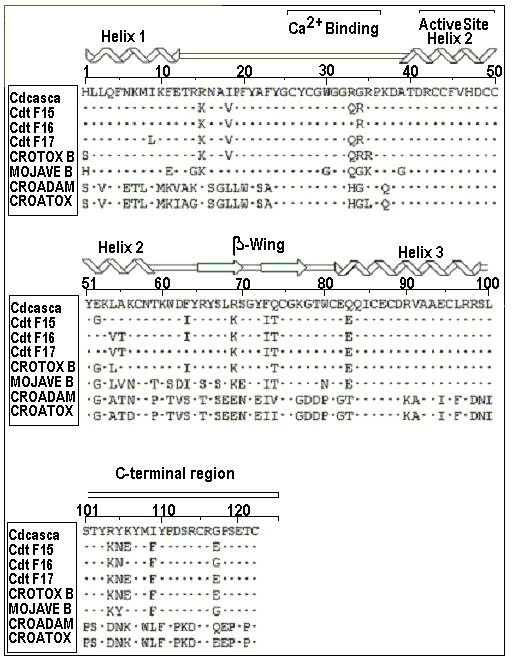
Amino acid sequence of PLA2 isolated from Crotalus durissus cascavella and its estimated secondary structure. The calcium binding loop, active site and C-terminal region are present in the sequence. Note the highly conserved calcium binding loop and active site, and an extensive portion of basic amino acid residues, such as Arg and Lys, in the C-terminal. This PLA2 showed high homology with other PLA2s, such as the isoforms from Crotalus durissus terrificus (Cdt F15, F16 and F17). Crotoxin B (cloned basic subunit of crotoxin) and mojave b (PLA2 subunit of Crotalus scutulatus scutulatus).